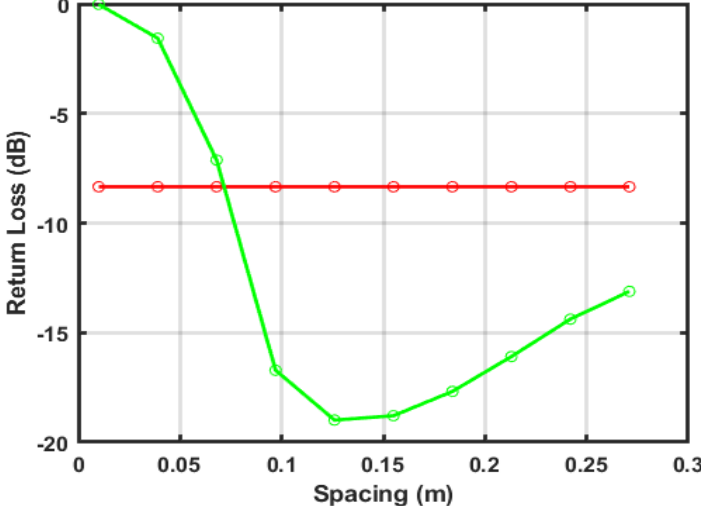
Figure 8. Average return losses in the frequency band [470 MHz, 806 MHz]. Radome of wire = 0.8 mmØ, and thickness = 16 mm: (-o-) without helical wire. (-o-) with helical wire, spacing s = 0.01–0.27 m.